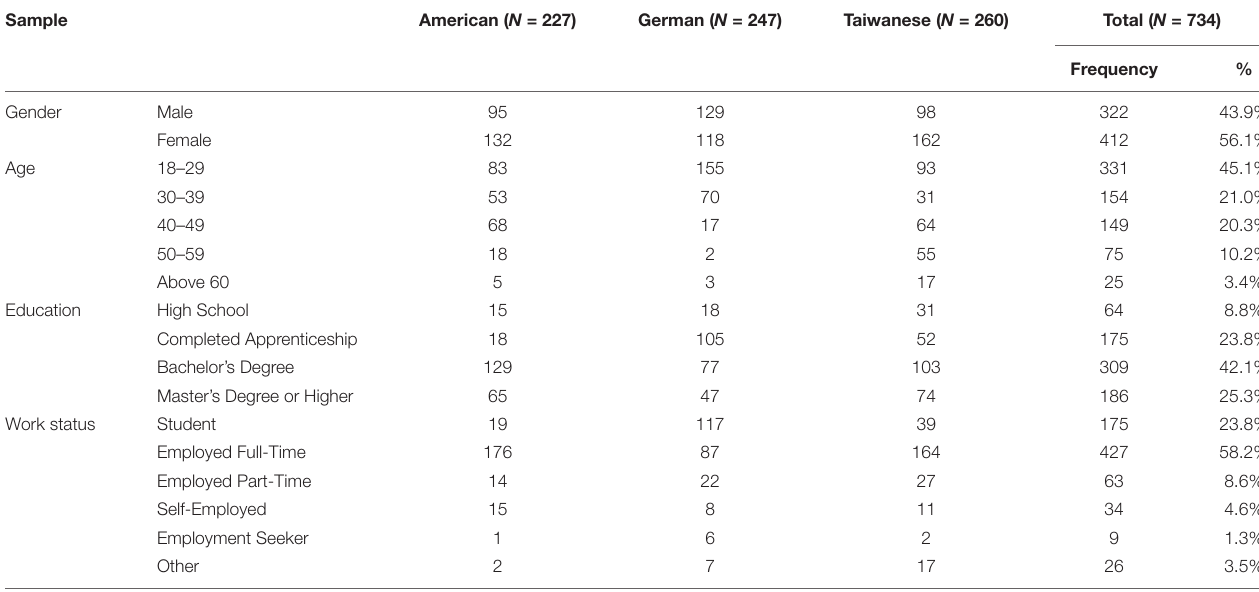
TABLE 1 | Descriptive statistics of the participants in the present study. Sample